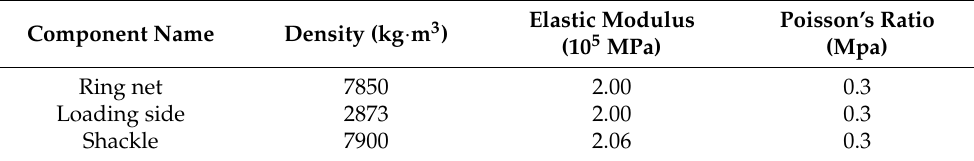
Table 6. Model parameters in the static punching test.